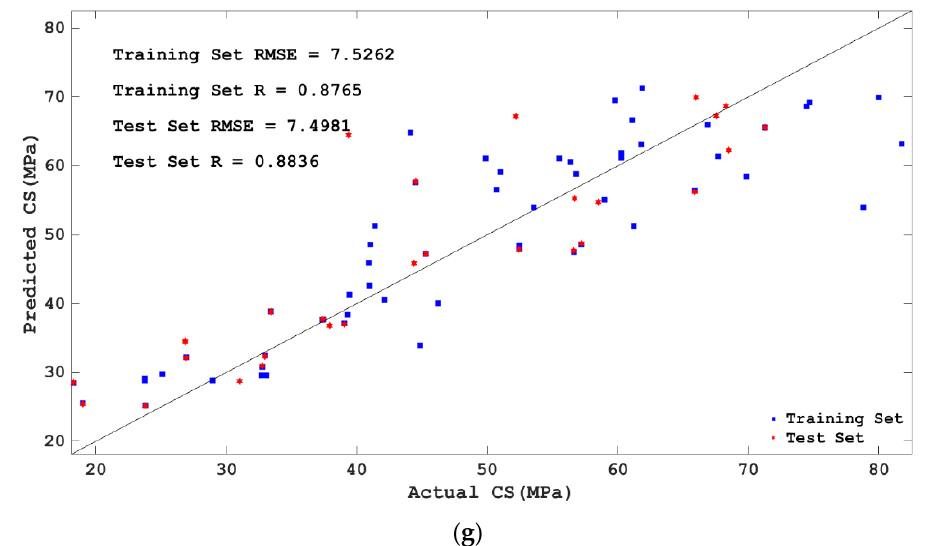
Figure 10. Comparison of predicted value with the actual value of different models. ( a ) BPNN; ( b ) SVM; ( c ) DT; ( d ) RF; ( e ) KNN; ( f ) LR; ( g ) MLR.